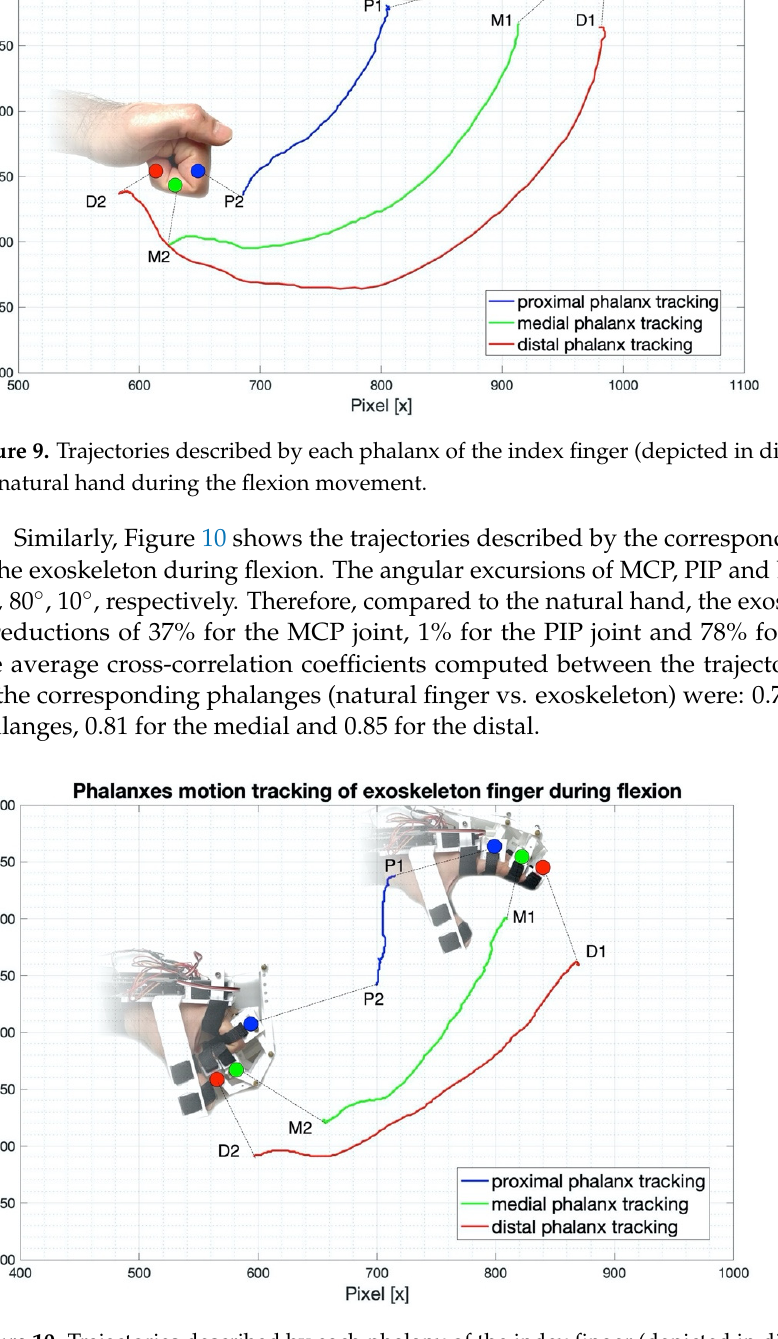
Figure 8. Finger force and actuator torque in the simulation environment: panels ( A , B ) show the finger force and the related actuator torque, from the extended position to the flexed position of the finger; panels ( C , D ) show the finger force and the related actuator torque, from the flexed position to the extended position.